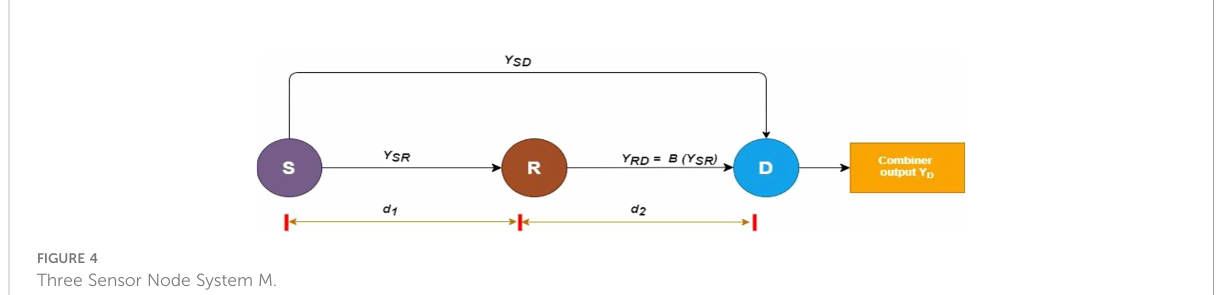
FIGURE 4 Three Sensor Node System